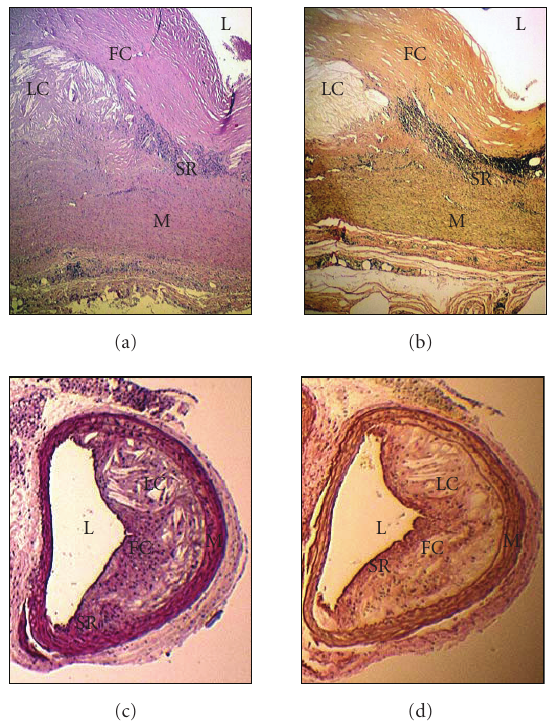
Figure 2: Morphological features of advanced atherosclerotic plaques. (a) and (b) show sections from a human carotid artery; (c) and (d) are sections from an apoE deficient mouse brachiocephalic artery. Sections (a) and (c) have been stained with haematoxylin and eosin and sections (b) and (d) with van Gieson staining (used to demonstrate the increase of collagen deposition and development of elastic fibres, a characteristic feature of the atherogenic process. A positive staining is depicted by a brown colour). L: lumen of the vessel; SR: shoulder region (it is believed to contain large numbers of proinflammatory cells including macrophages and lymphocytes, and it is the site related with the onset of the development of the atherosclerotic plaque); FC: fibrous cap (It also contains large numbers of mononuclear infiltrate and smooth muscle cells that have migrated from the media layer (M) and proliferated in response to the local inflammatory stimuli. It is also characterised by high collagen deposition and little or no endothelial cells); LC: lipid core (it contains mainly macrophage and smooth muscle cell-derived foam cells, apoptotic cells, and cholesterol crystals. Older lesions may also display signs of calcification). Contrasting di ff erences can be recognised in the anatomic development of atherosclerotic plaques between human and mouse including the hypertrophy associated with the proliferation of the smooth muscle cells in the media layer and the fibrous cap. In humans, some lesions may also contain signs of intraplaque haemorrhage. Signs of plaque rupture are usually best recognised in mouse (reviewed in [13, 14]).